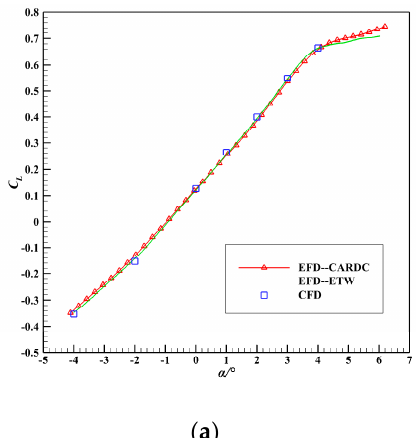
parameters L = 400 mm/H = L2 + 100 mm).